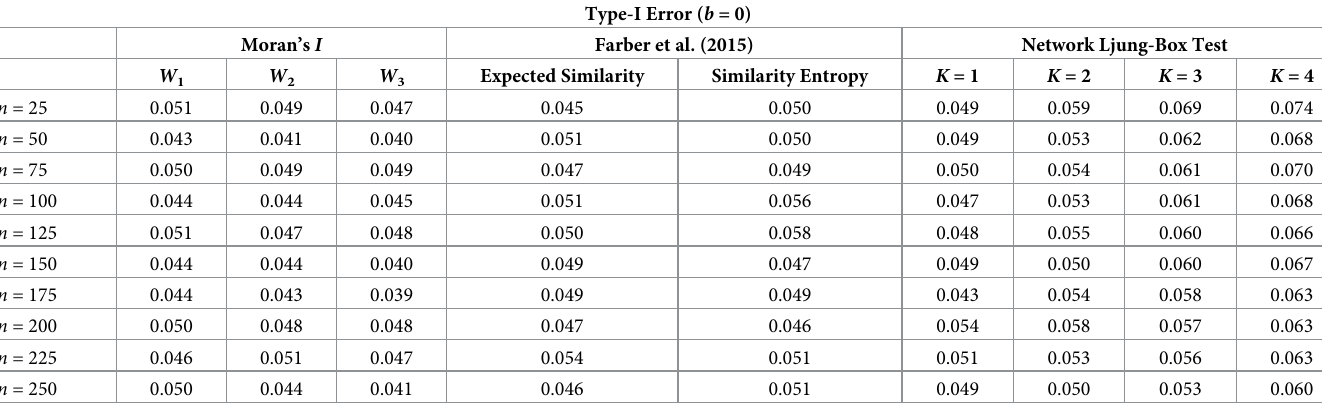
Table 1. Type-I error rates. Type-I error rates of tests for different values of K and n .